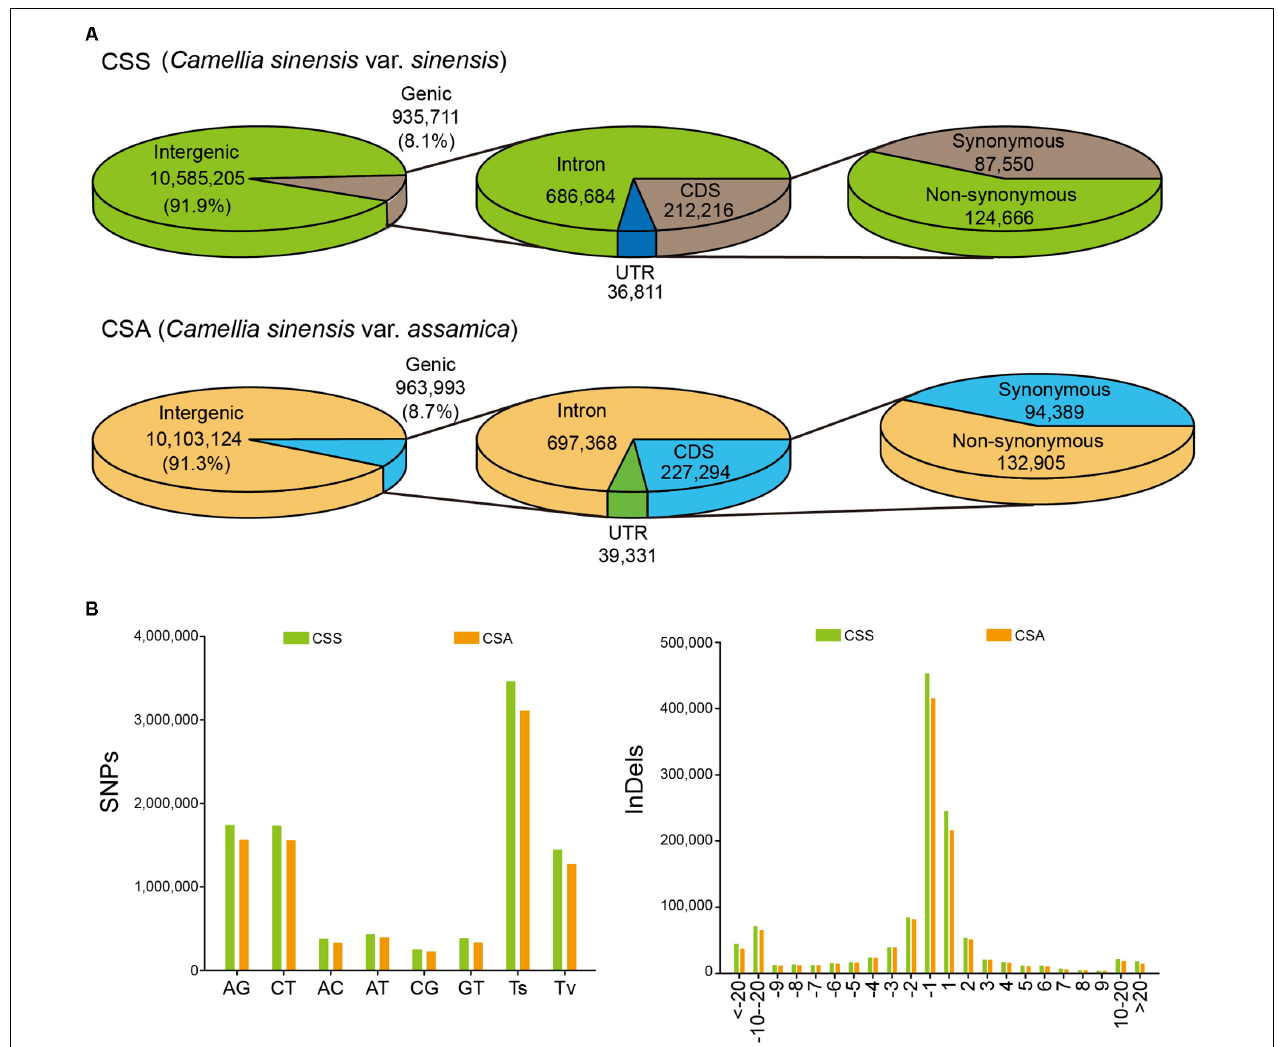
FIGURE 1 | Classification and distribution of identified SNPs/indels among 30 samples. (A) Annotation of SNPs identified in CSS and CSA subgroup. (B) The mutation pattern (SNP) and the length distribution (indel) of unique variations for CSS and CSA subgroup,